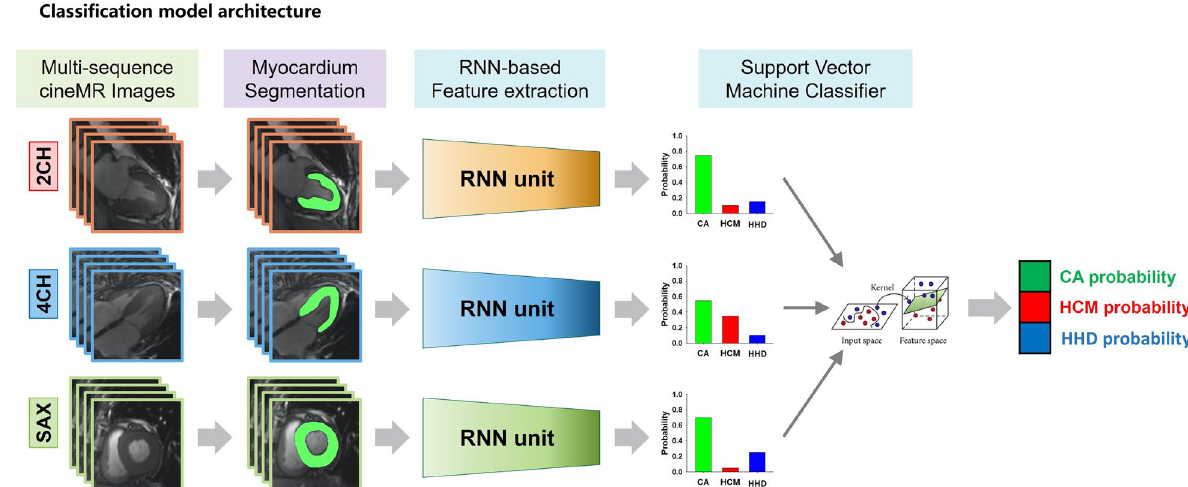
Fig. 3 Schematic of the fully automatic framework for predicting the cause of left ventricular hypertrophy through cine MR images. 2CH— two‑chamber, 4CH—four‑chamber, SAX—short